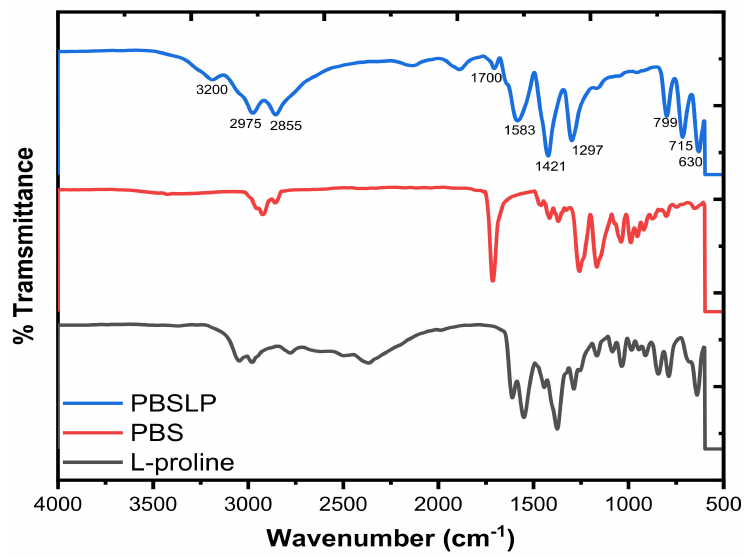
Figure 1. FTIR spectra of L-proline, polybutylene(succinate) (PBS), and poly(butylene-succinate)- L-proline (PBSLP).